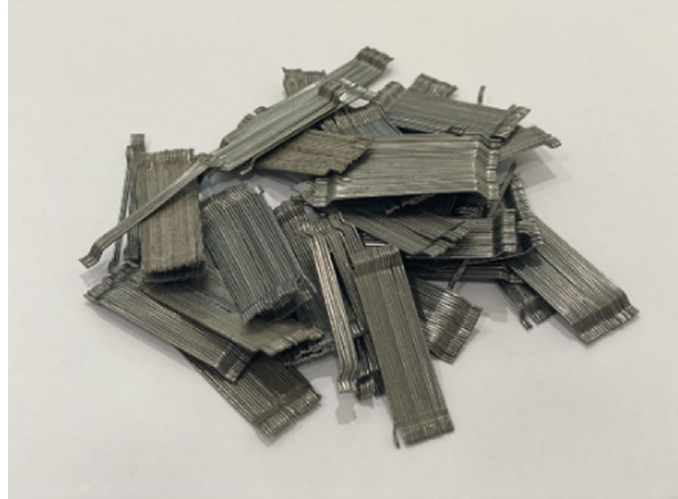
Figure 2. Steel fibers used in the current study.